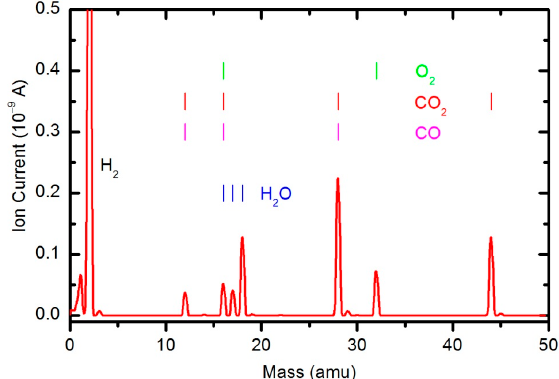
Figure 12. A mass spectrum measured in a chamber loaded with PURPEG samples after plasma treatment for 600 s. The pressure was 33 Pa and forward power 150 W.